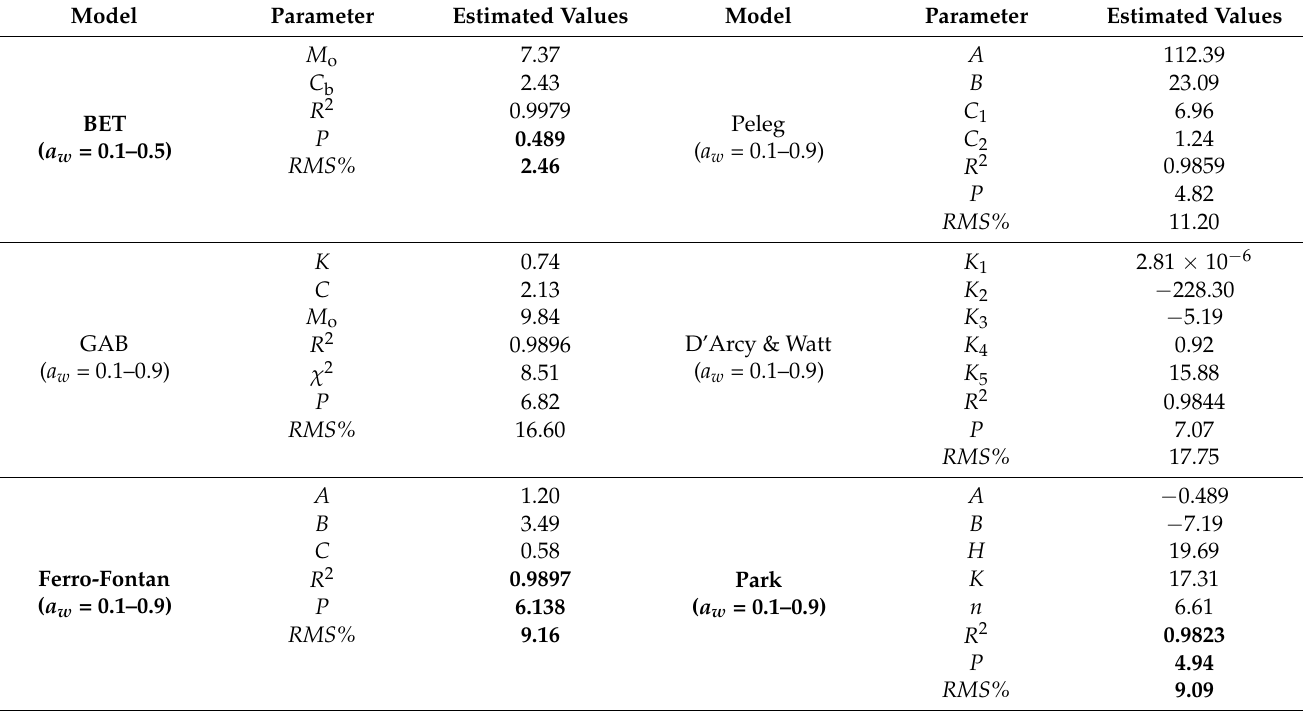
Table 2. Moisture sorption models of electrospun tags and their calculated